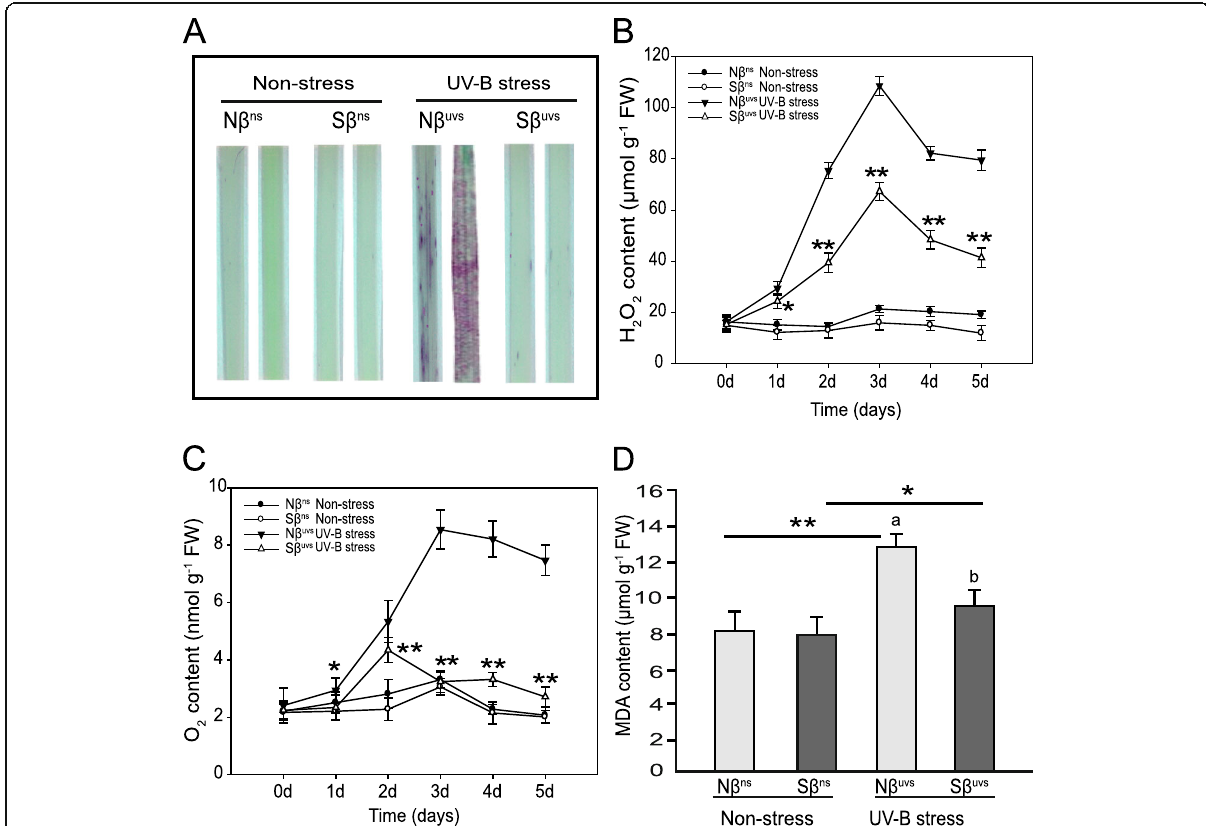
Fig. 4 Differences in ROS accumulation of N β and S β plants under non-stress and stress conditions. A The N β and S β leaves were evaluated for superoxide anions using NBT staining under non-stress and UV-B stress; further, the contents of B H 2 O 2 and C O 2 were measured each day during the entire period of UV-B stress (1 – 5 days). Evaluation of lipid peroxidation was conducted by measuring D MDA levels. The means with different letters are significantly different (P < 0.05) within the same treatment. Lines with asterisks indicate significant differences between non- stress and UV-B stress conditions of the same plants (N β ns vs. N β uvs and S β ns vs. S β uvs ), as determined by Student ’ s t test (* P < 0.05, ** P <